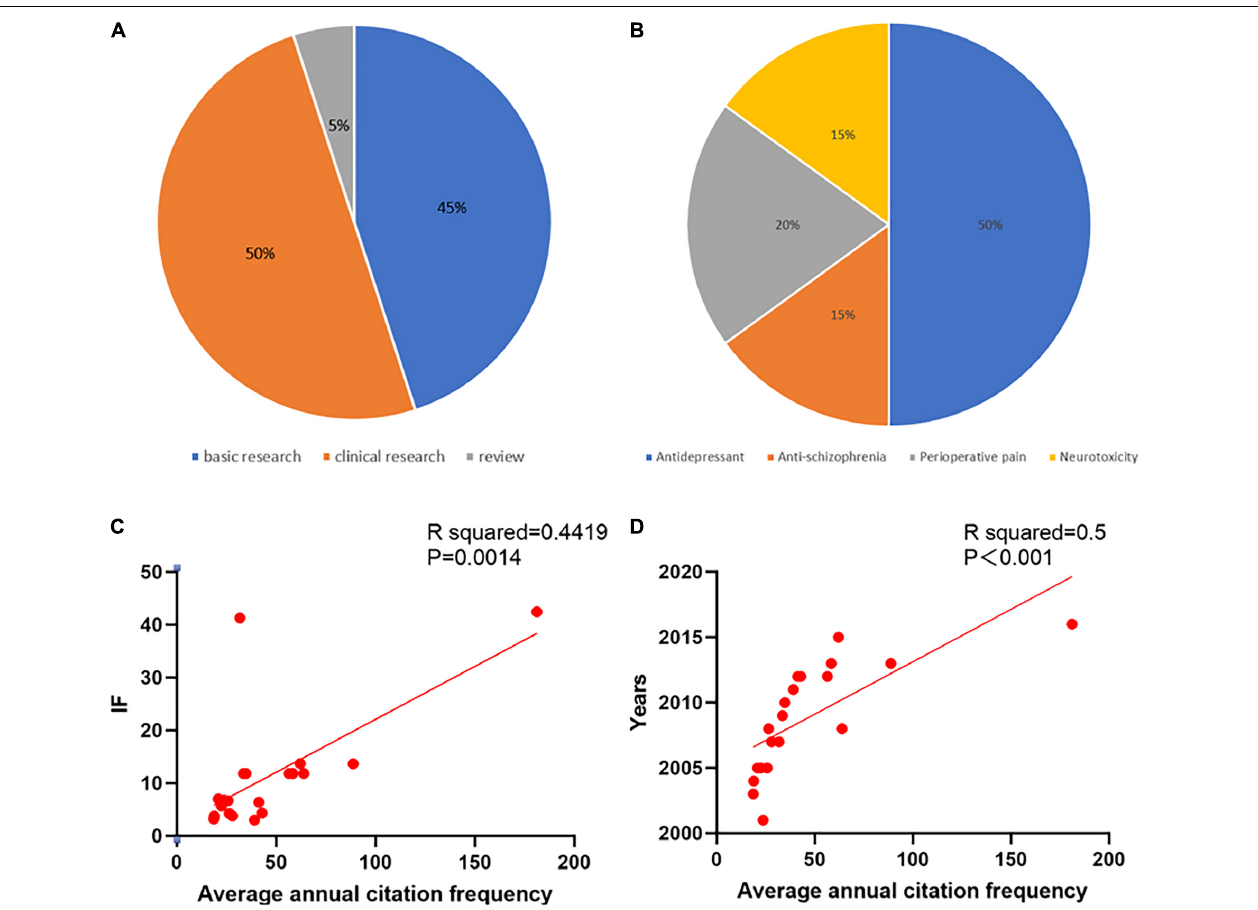
FIGURE 5 | The classification and correlation analysis of the top 20 cited articles on ketamine. (A) The proportions of the top 20 ketamine research article classifications. (B) The proportions of the research content categories of the top 20 cited articles on ketamine. (C) There was a significant correlation between the average number of citations per year and the impact factor based on the correlation analysis (R squared = 0.4419; P = 0.0014). (D) There was a significant correlation between the average number of citations per year and the year of the analysis (R squared = 0.5; P <